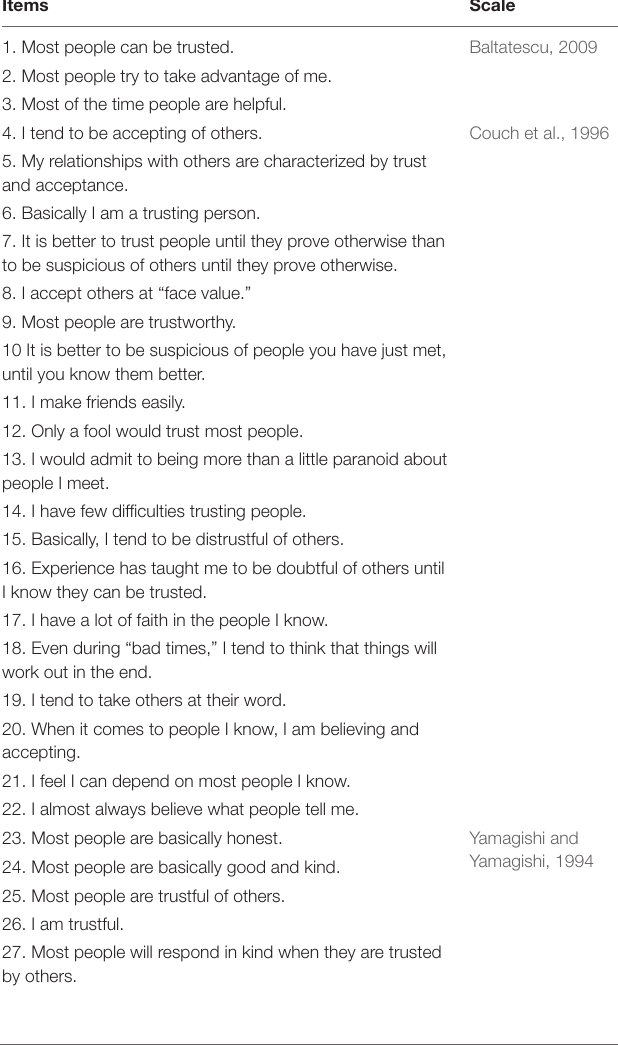
TABLE 2 | All 27 items used for testing in Study